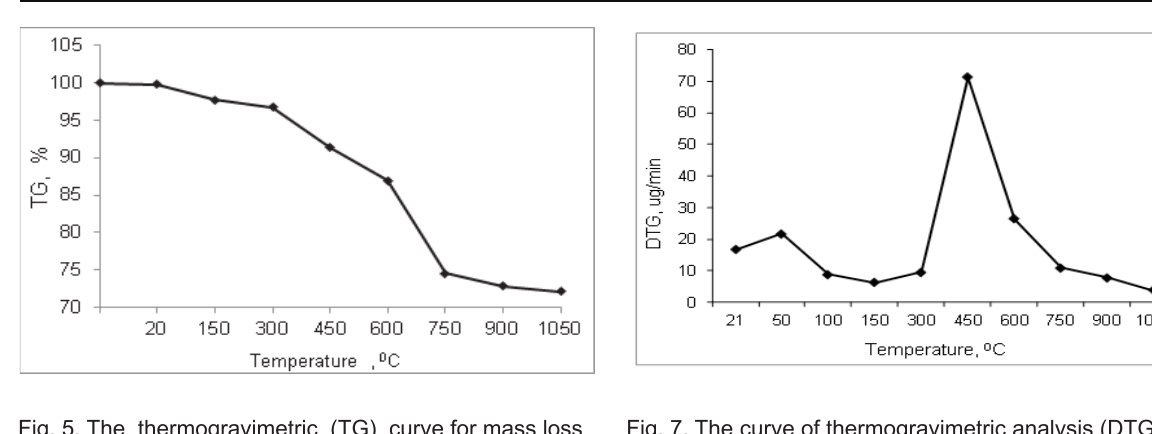
Fig. 5. The thermogravimetric (TG) curve for mass loss of Uvurjargalant’s oil shale during thermal decom- position process